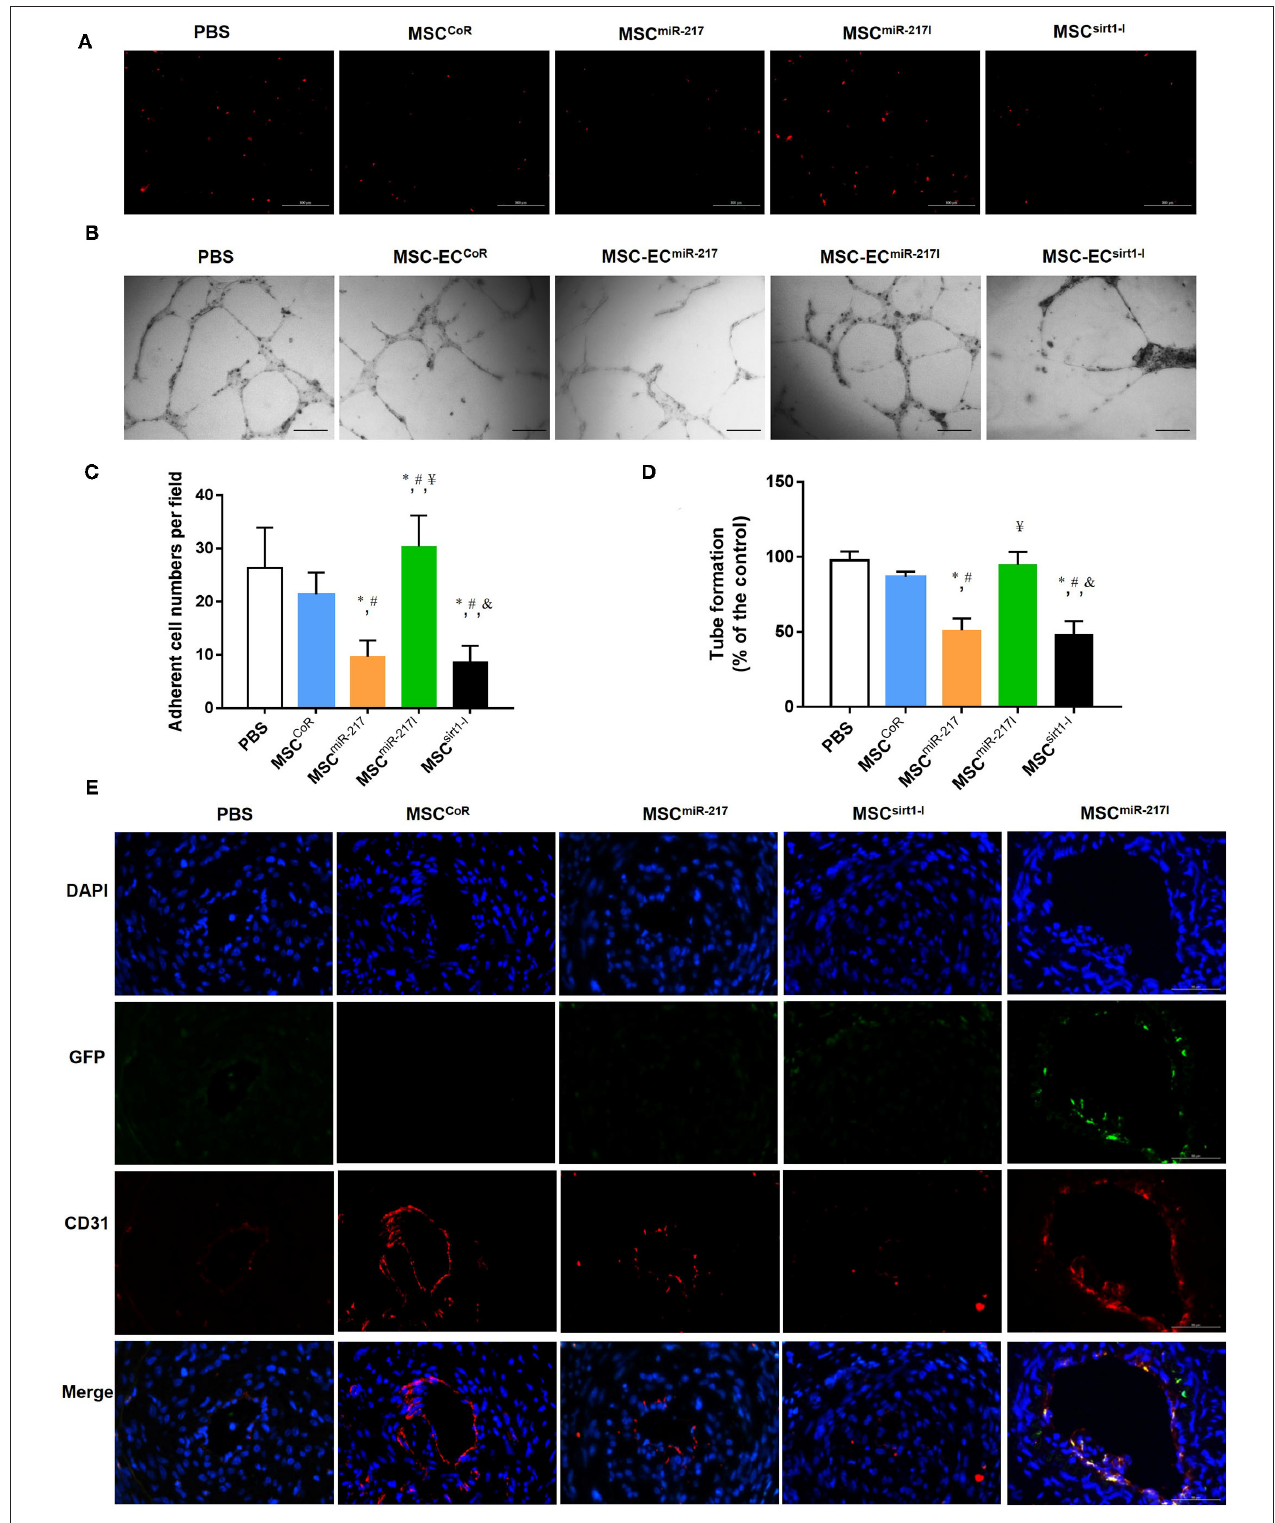
FIGURE 5 | miR-217 inhibition can improve MSC treatment efficiency for IH by increasing the differentiation potential into endothelial cells at the injury site. (A) The adhesion properties of MSCs to the endothelial monolayer after treatment with PBS, MSC CoR , MSC miR − 217 , MSC miR − 217I or MSC Sirt1 − I . (B) Assessment of